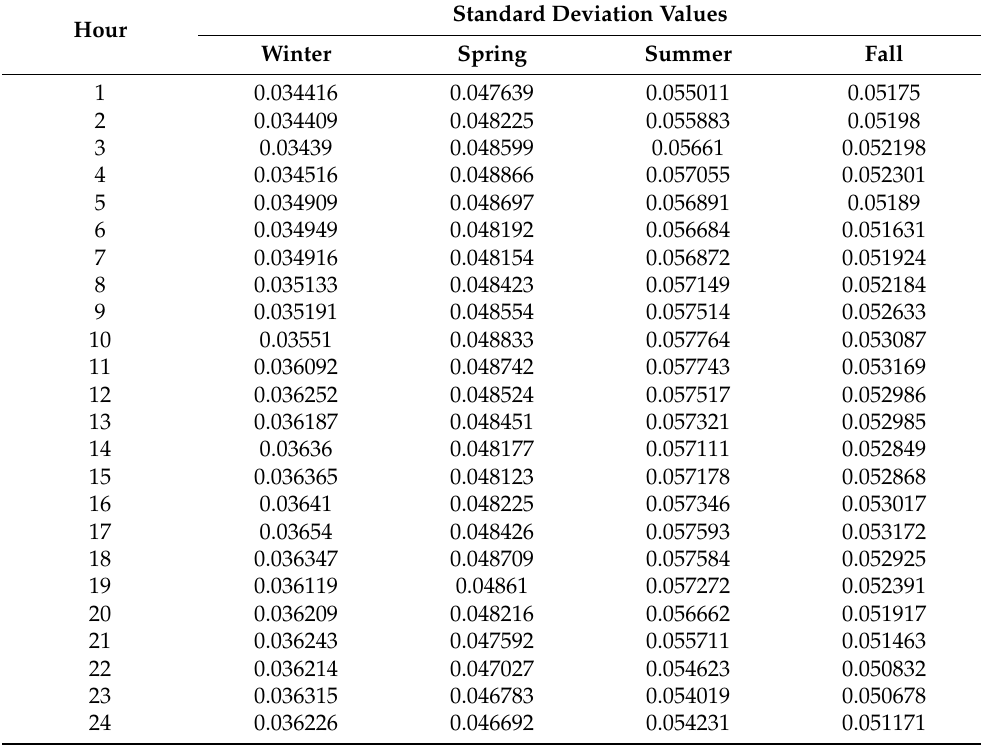
Table 7. Standard deviation of load demand for different seasons after DR program